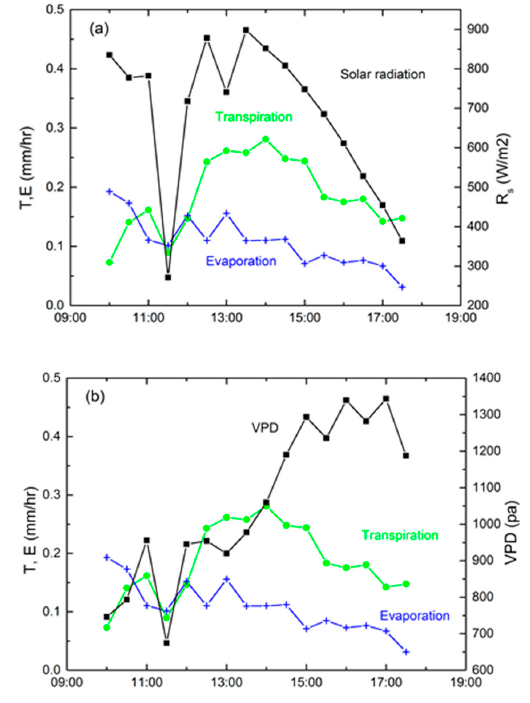
Figure 9. Half-hourly plots of soil evaporation (E), transpiration (T), and ( a ) incoming solar radiation and ( b ) vapor pressure deficit (VPD) on 26 June.